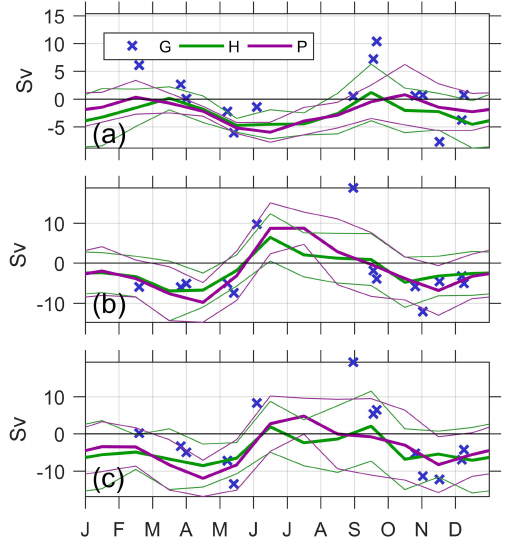
Figure 5. Meridional volume transport across 8 ◦ N from the Sri Lankan east coast to 82.5 ◦ E (dashed line in Fig. 2) calculated from glider geostrophic velocity referenced to the depth-averaged veloc- ity (G; blue cross) and total velocity fields from HYCOM (H; thick green line) and POP (P; thick purple line) over the 0–200m (a) , 200–1000m (b) , and 0–1000m (c) layers. Thin lines designate the mean value ± 1 standard deviation.